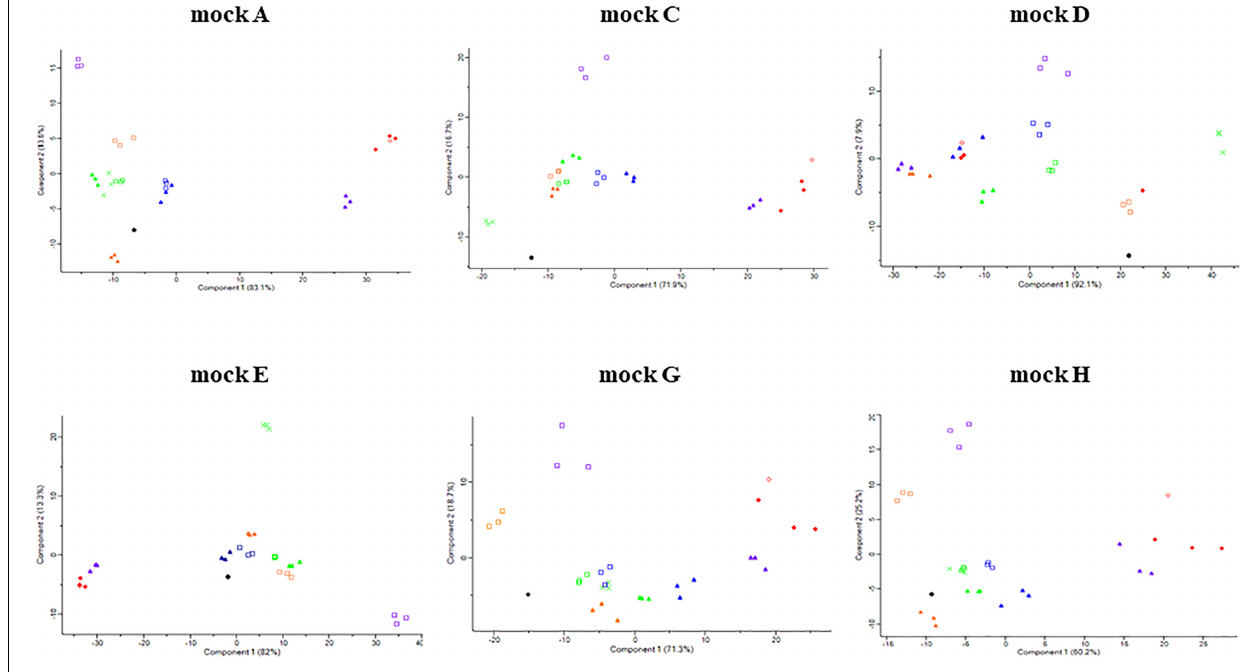
FIGURE 4 | Principle component analysis (PCA) of original and sequenced mock communities. The symbols are based on the following criteria: (cid:108) , original; (cid:3) , MiSeq; (cid:115) , IonTorrent; X, MGIseq-2000; (cid:117) , Sequel II; and , MinION. The orange, green, blue, violet, and red color indicate V1-V2, V3, V4, V1-V3, and V1-V9 regions, (cid:51)